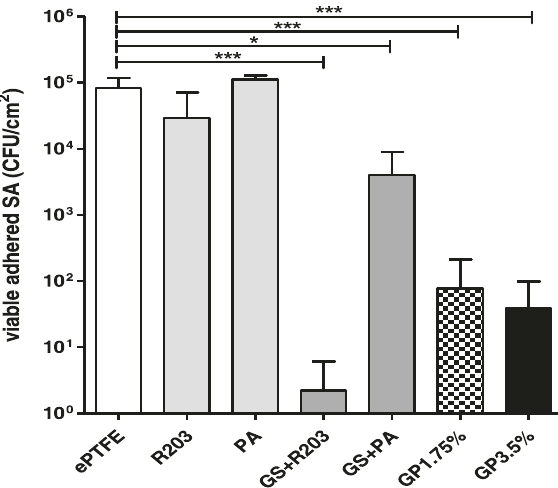
Fig. 5 Numbers of adhered SA on untreated, non-gentamicin and gentamicin-coated ePTFE